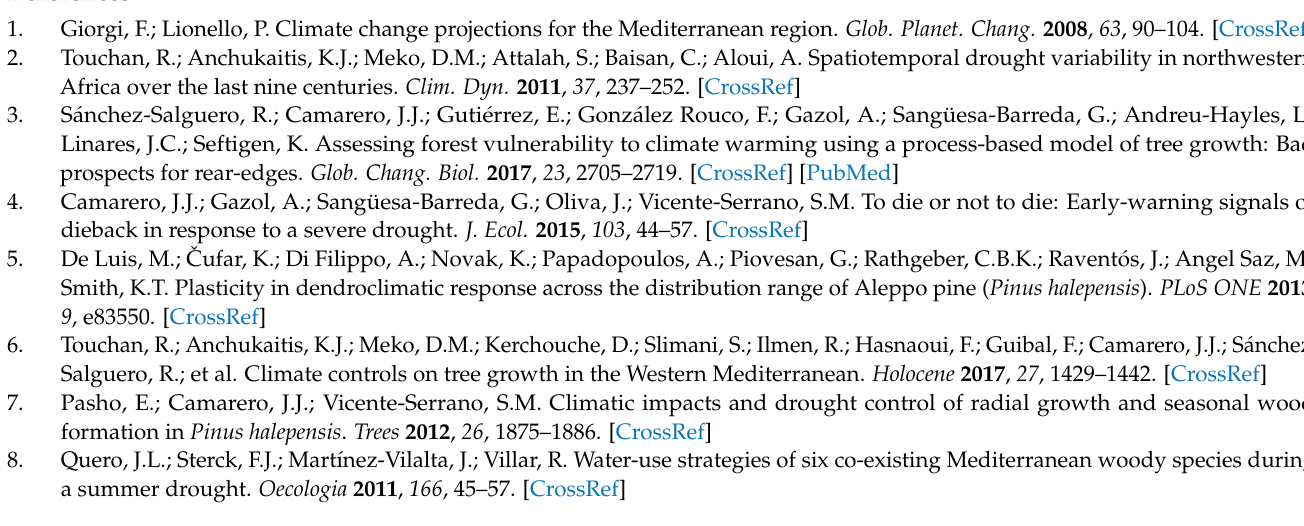
Figure S3. Comparison of the year-to-year Ephedra growth (RWI, ring width index) and December to January precipitation variability in the very dry site. The selected climate variable showed the highest association with the mean series of ring-width index for the best replicated period showing a correlation of r = 0.59 ( p = 0.0009), Table S1. Model selection for growth rate (RWI, ring width indices) response to 12-month June SPEI between dry and very dry sites (sites) and between shrubs and trees (growth form) considering the period 1989–2019. The coefficients for the 12-month June SPEI (SPEI) and the factors (+ if included) of each proposed linear mixed-effect model are shown together with the degrees of freedom, the change in AIC and the Akaike weight. The selected models are shown in bold, Table S2. Pearson correlation coefficients ( r ) calculated between mean series of observed and simulated ring width indices for the cross-validated sub-periods 1960–1990 and 1991–2019. Pearson correlation coefficients were always significant at the 0.05 level. Statistics of the Bayesian estimation of the growth response parameters (T1, T2, M1, and M2 for minimum and optimal temperature and soil moisture values, respectively) are also